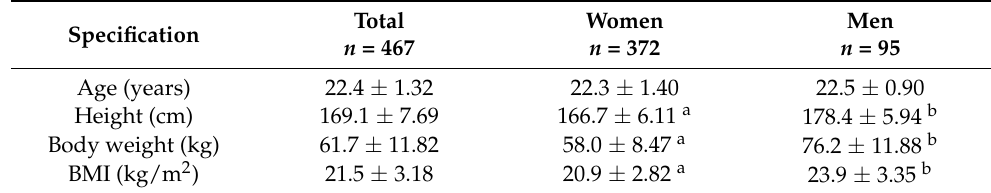
Table 2. Age, weight and height of